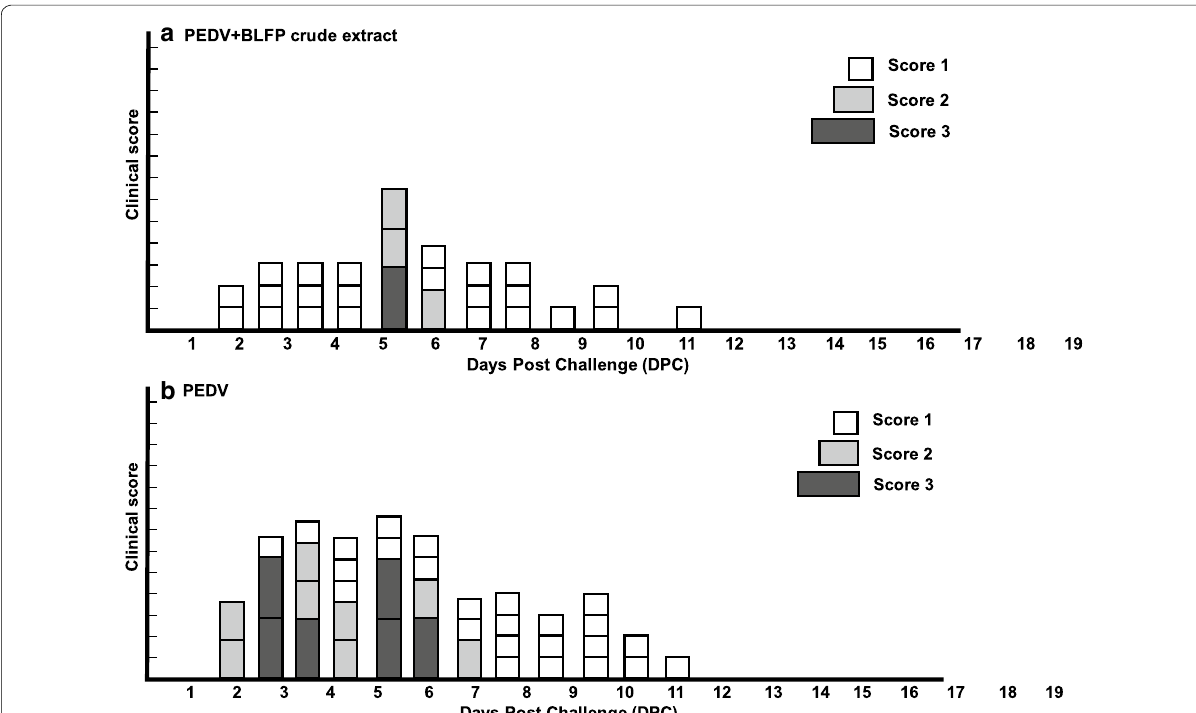
Fig. 2 Clinical scoring of fecal consistency. Compared to PEDV‑infected groups, the appearance and duration of typical diarrhea (score 2–3) were reduced in the PEDV BLFP +